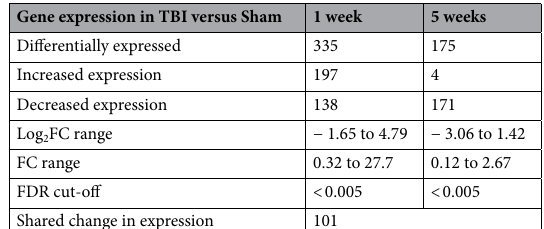
Table 1. Summary of RNA sequencing results of retinal transcripts from bTBI- versus sham-treated mice. FC fold change FDR false discovery rate.